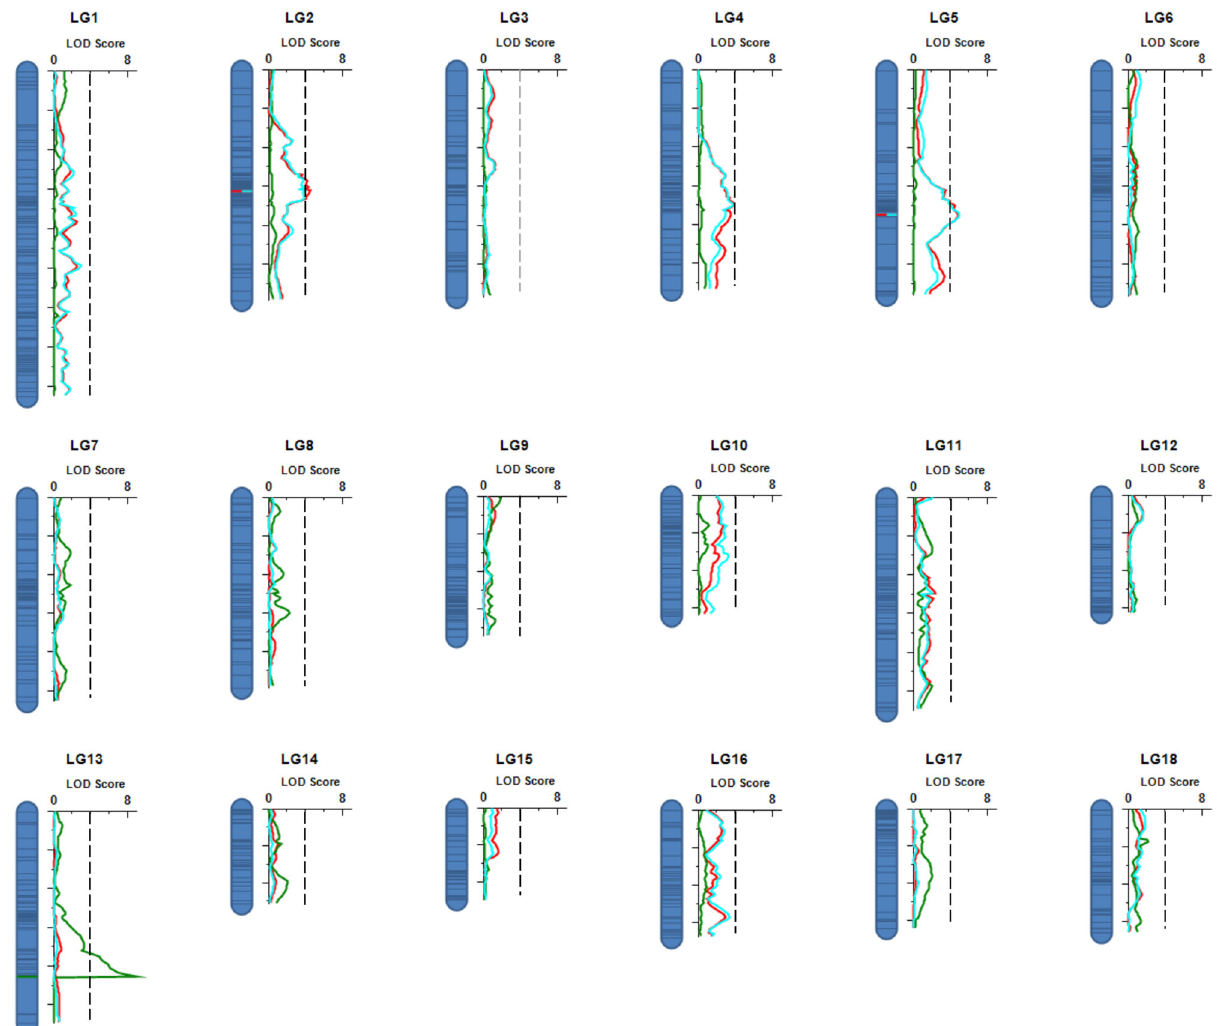
Fig. 6 LOD pro fi le of QTLs detected on linkage group 1 (LG1) to LG18 in B. glabrata . Two QTLs were detected on LG2 and LG5 for host resistance/ susceptibility (in red) and parasite abundance (in blue), while one QTL detected on LG 13 for pigmentation (in green). Gray dot lines show threshold LOD score (LOD = 4) used for detecting